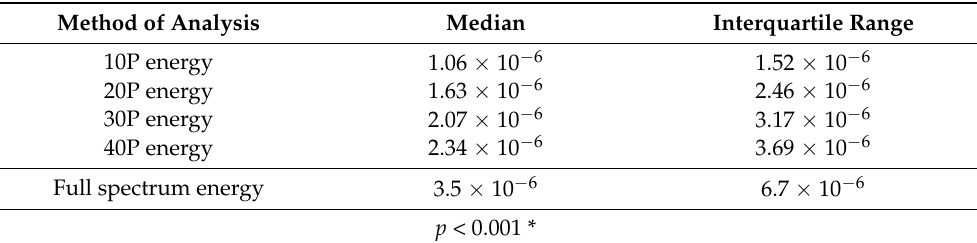
Table 2. Comparison of the signal energy using four methods (10P, 20P, 30P or 40P) of primer frequency contributors and the signal energy of the full spectrum.